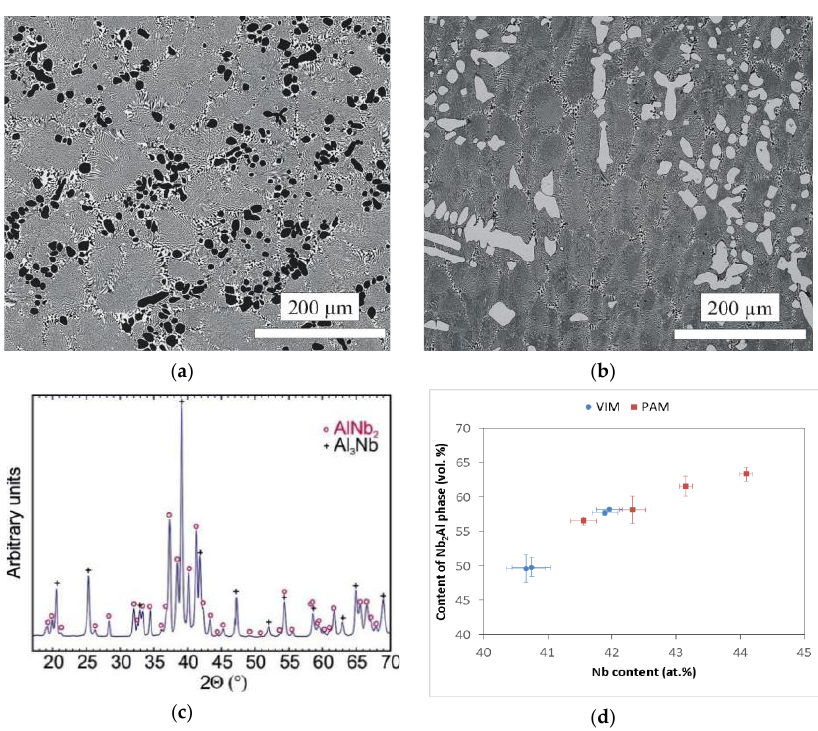
Figure 4. ( a ) SEM-BSE image of the Nb – Al-VIM-1 alloy; ( b ) SEM-BSE image of the Nb – Al-PAM-1 alloy; ( c ) X-ray diffraction patterns of the Nb – Al-VIM-1 alloy; ( d ) dependence between content of Nb 2 Al phase and Nb content in Nb – Al